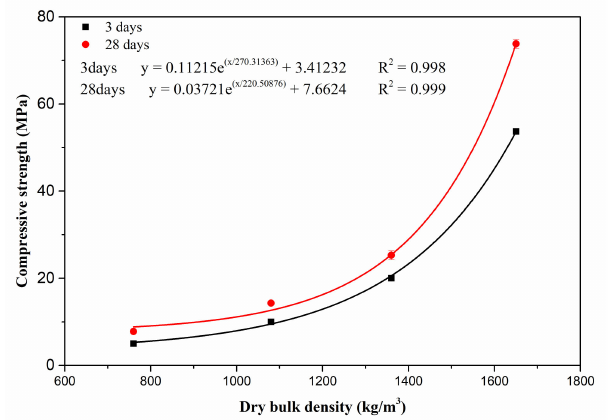
Figure 12. Compressive strength of porous samples.